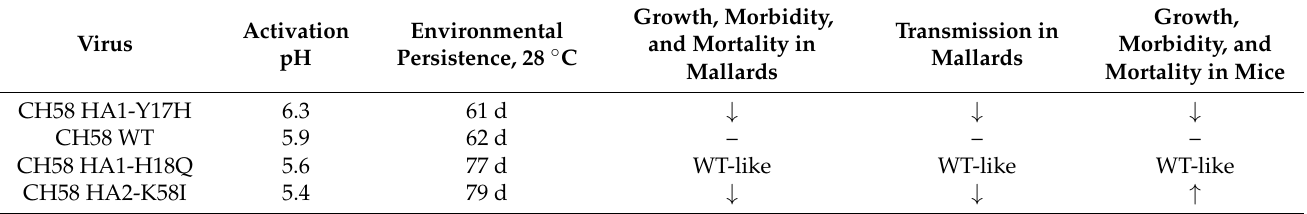
Table 8. A/chicken/Vietnam/C58/04 (H5N1) HA stability variants in mallards and mice [99,194]. Activation Environmental Virus